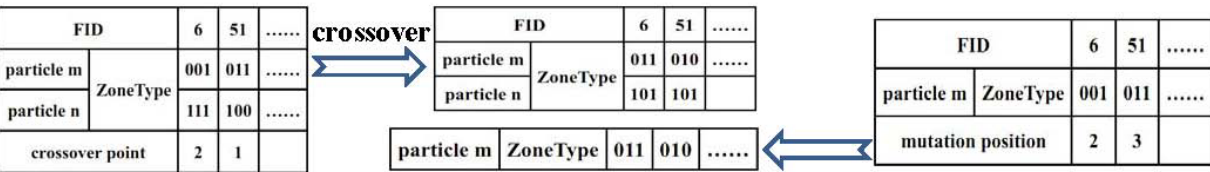
Figure 6. The crossover and mutation